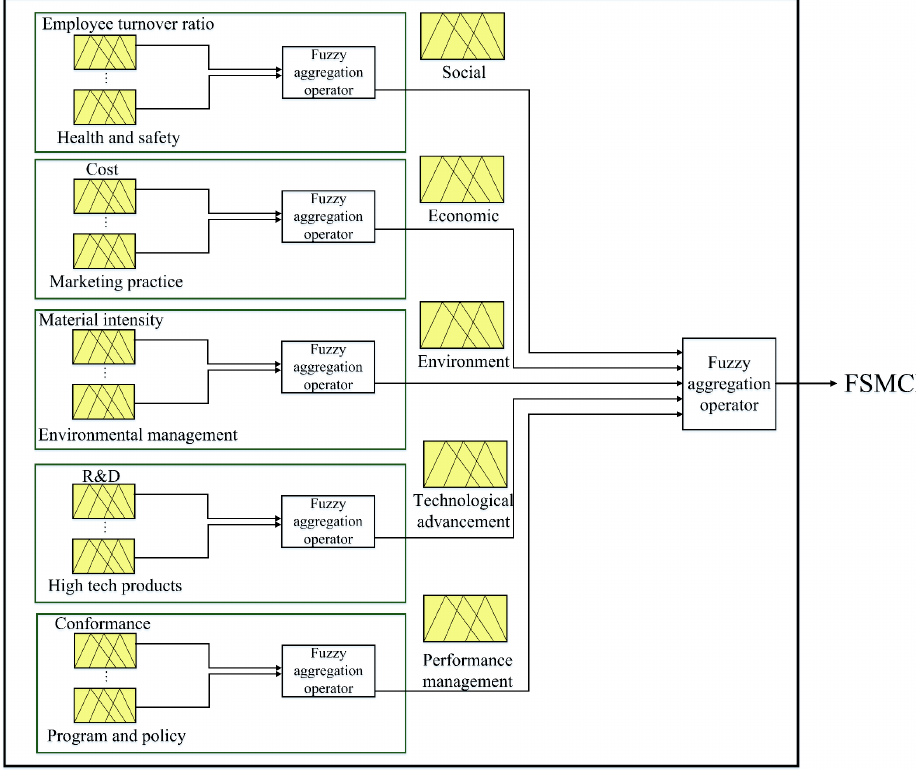
Figure 2. The proposed sustainability assessment model.